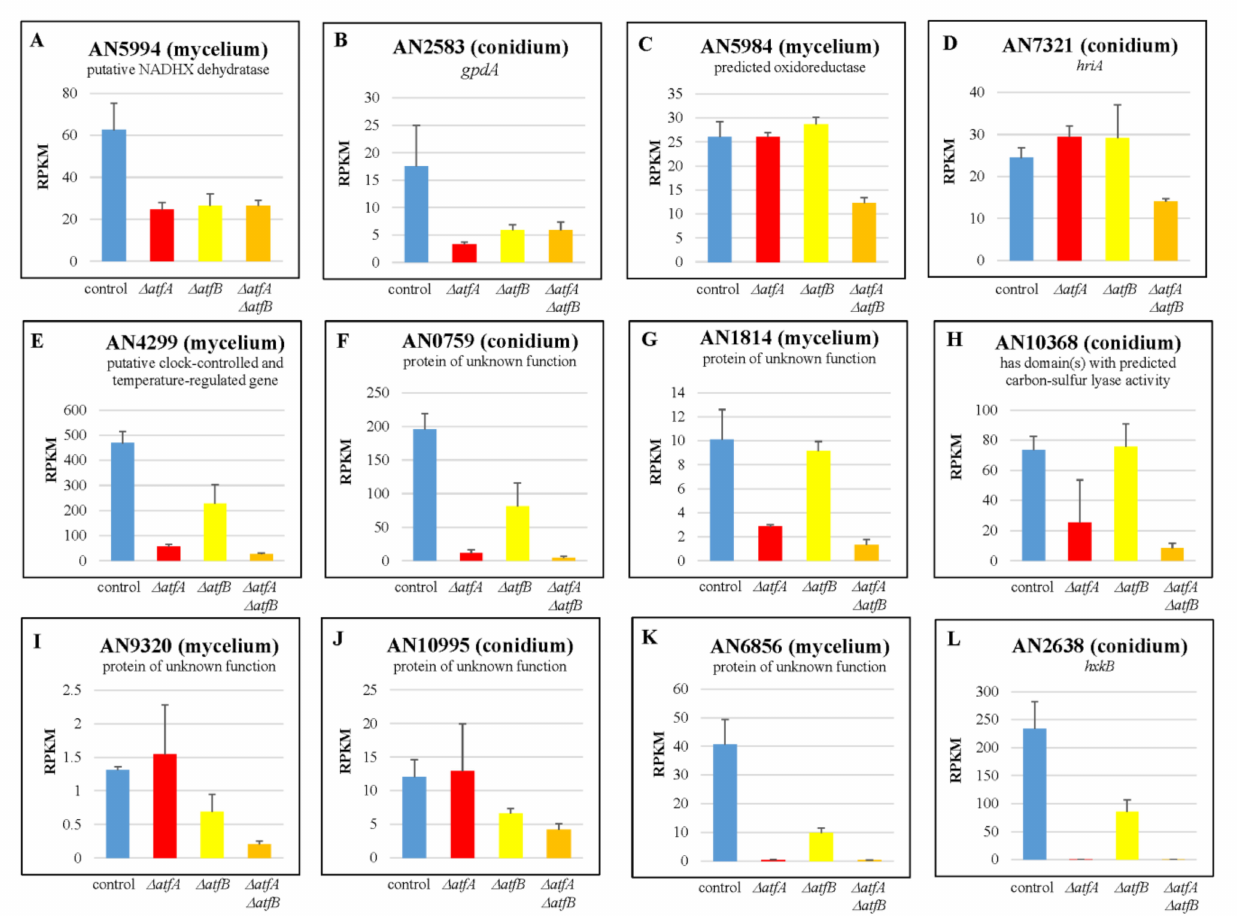
Figure 2. Transcriptional pattern of selected genes potentially regulated by both AtfA and